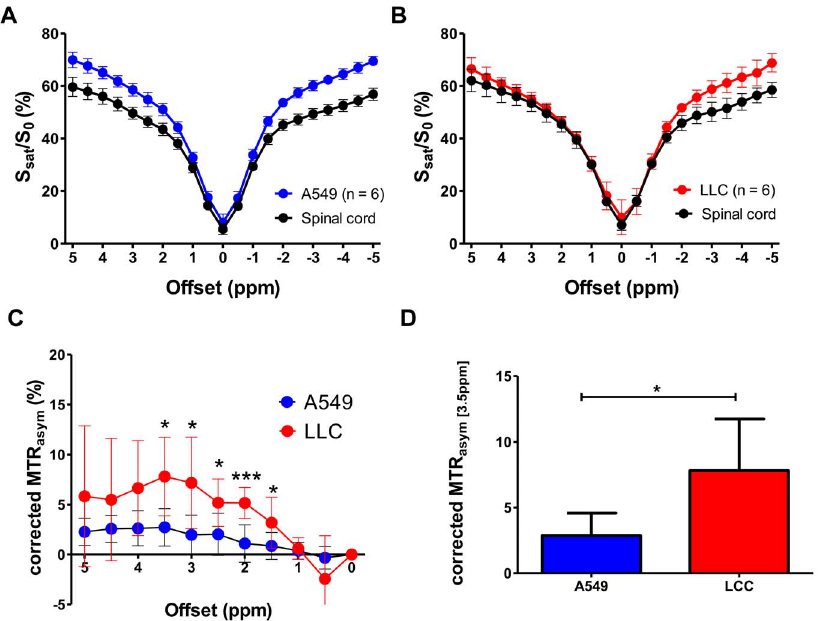
Figure 3. Analyses for Z-spectrum and MTR asym of both types of lung tumors. Z-spectra of A549 ( A ) and LLC ( B ) tumors compared to that of spinal cord as a reference show that the LLC tumor has a larger CEST effect than A549 tumor. Corrected MTR asym spectra of A549 and LLC ( C ) and corrected MTR asym at 3.5 ppm ( D ) show that LLC has a larger APT effect than A549, which may be related to the malignancy of the tumors. *, P # 0.05; **, P # 0.01; ***, P # 0.001 by Student’s t-test.